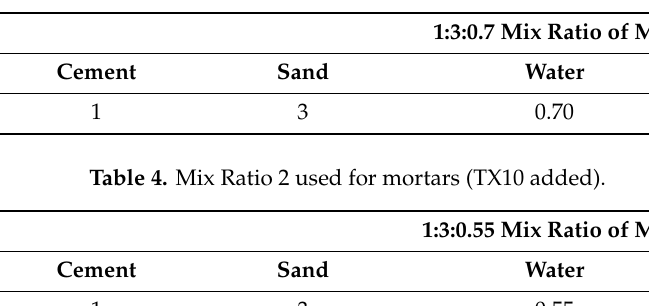
Table 3. Mix Ratio 1 used for mortars (no TX10).